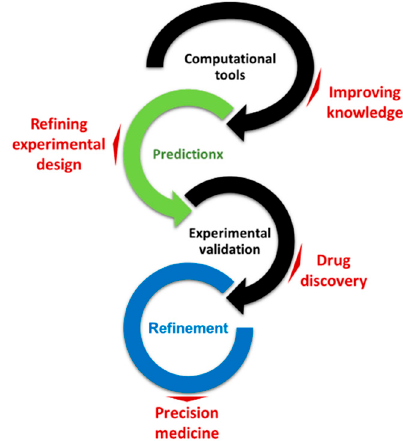
Figure 1. Schematic illustration of the refinement process involving several integrative approaches and powered by new income and technologies. Adapted from [48]. Copyright Taylor & Francis, 2016.